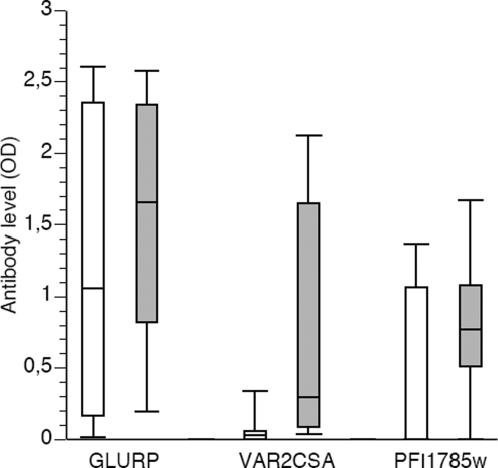
Recognition of PFI1785w recombinant protein (NP561) by sera from malaria exposed individuals assessed by ELISA.ELISA was carried out on NP561, DBL5-ε of VAR2CSA and GLURP coated plates. The levels of IgG expressed as OD values are shown for exposed Ghanaian men (n = 30; white bars) and women (n = 30; grey bars). The top, bottom, and line through the middle of the box correspond to the 75th percentile, 25th percentile, and 50th percentile (median), respectively. The whiskers on the bottom extend from the 10th percentile and top 90th percentile. Plasma concentrations of anti-VAR2CSA and anti-NP561 IgG were significantly higher in the women group.